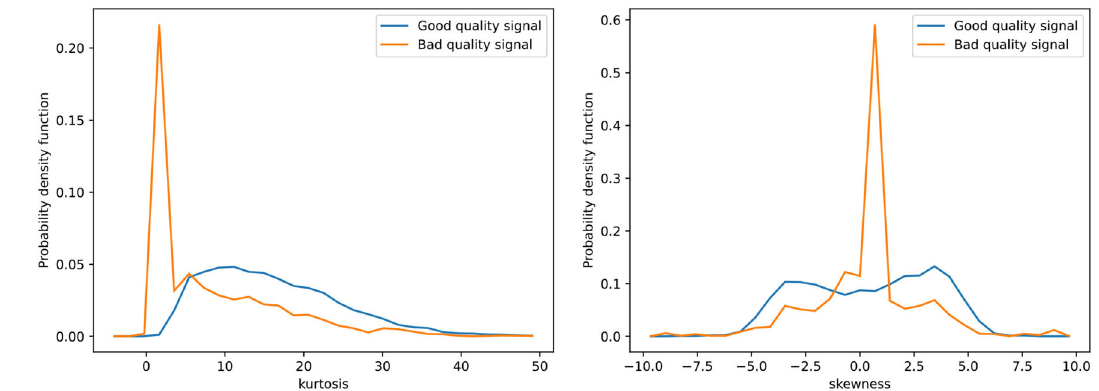
Fig. 12 The probability density function of kSQI and sSQI on set-a (9276 good quality and 2700 bad quality) before normalization